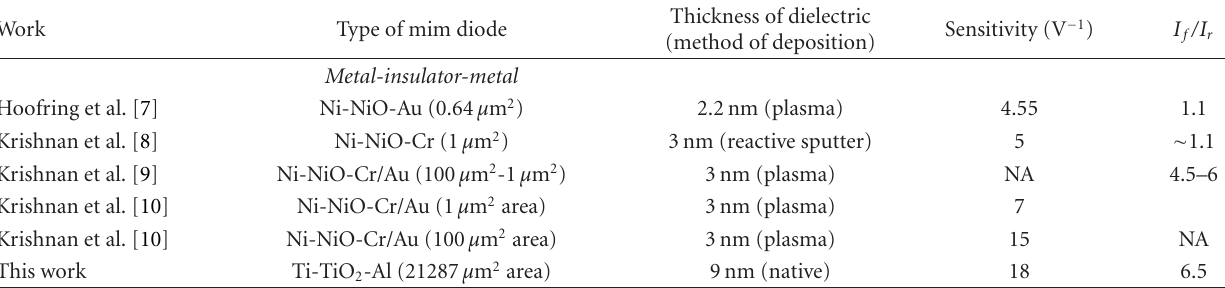
Table 1: Compares device characteristics of reported MIM diodes in the literature and this